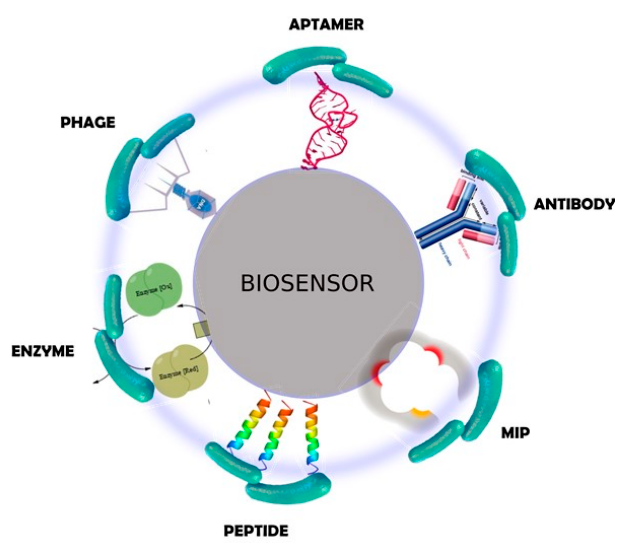
Figure 2. Schematic representation of different types of biorecognition elements for bacterial detection.